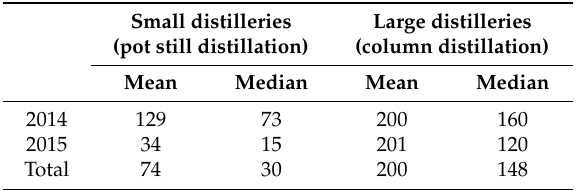
Table 3. Mean and median of the concentration of ethyl carbamate ( µ g/L) in cachaças produced from small distilleries (pot still distillation) and large distilleries (column distillation) during the years 2014 and 2015. Small distilleries Large distilleries (pot still distillation) (column distillation) Mean Median Mean Median 2014 129 73 200 160 2015 Mean = arithmetic mean; median = 50th